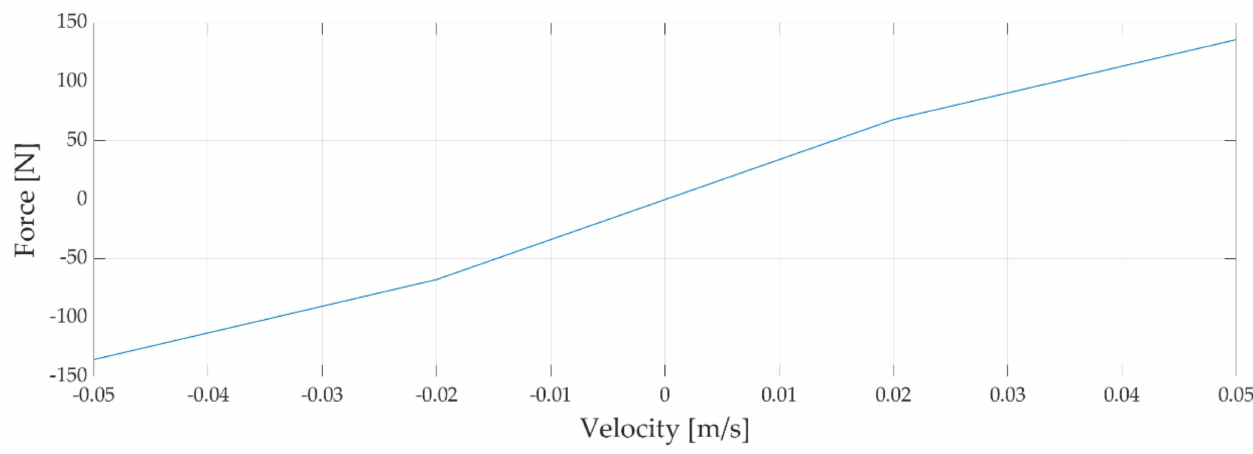
Figure A3. Hydraulically interconnected suspension model bounce damper Force/Velocity graph.